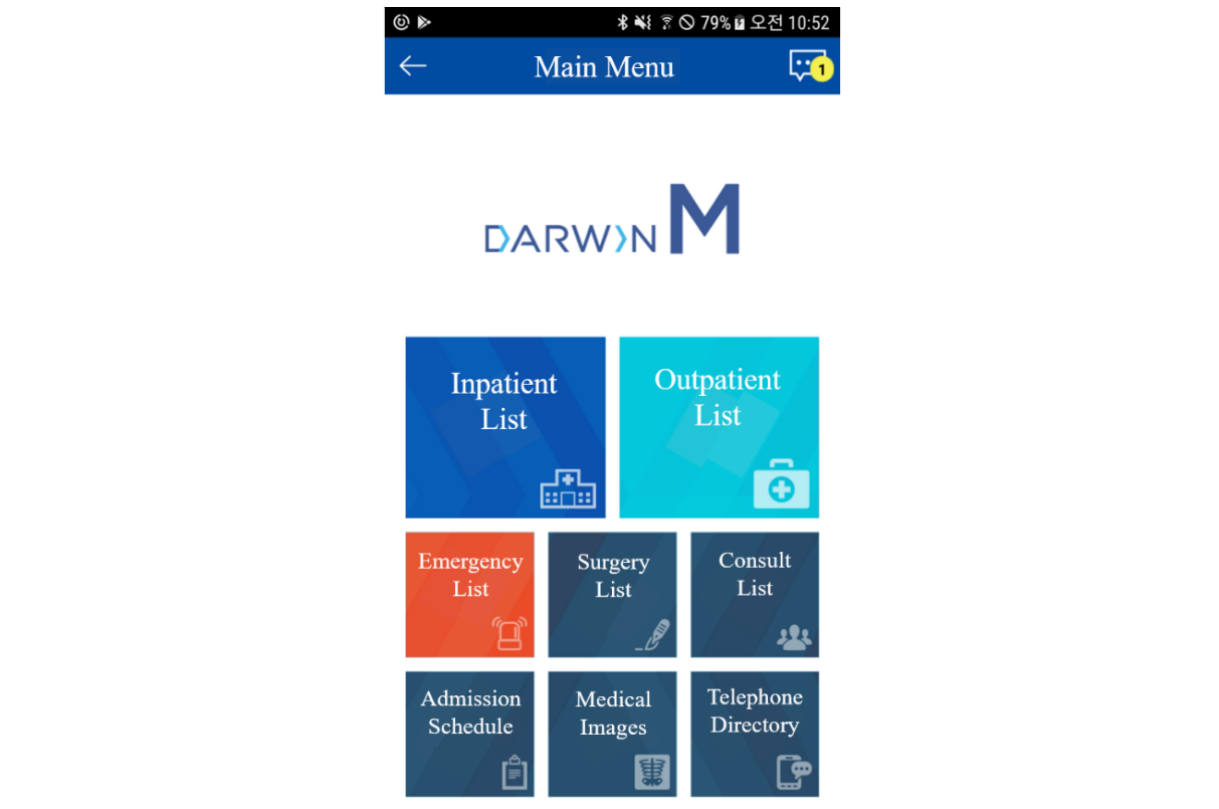
Figure 1. A screenshot of the mDARWIN screen displayed after login. The main menu functions as a portal for specific contents. mDARWIN: Data Analysis & Research Window for Integrated kNowledge.